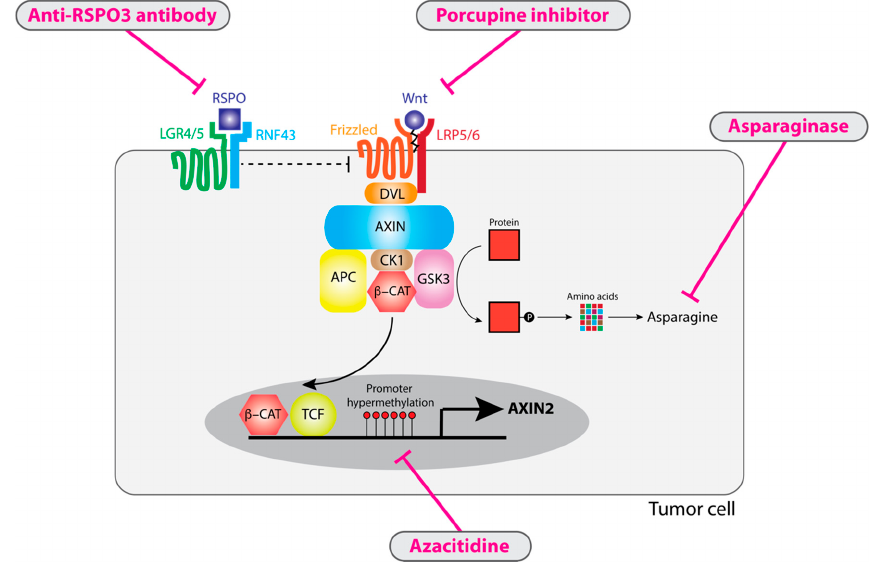
Figure 3. Target therapies for ligand-dependent tumors. All ligand-dependent tumors require Wnt ligands for pathway activation and so are sensitive to porcupine inhibitors that impair Wnt ligand activation. RSPO3 overexpression can be antagonized by anti-RSPO3 antibodies. Ligand-dependent GSK3 inhibition results in reduced proteasomal degradation to generate amino acids such as asparagine, making tumor cells sensitive to asparagine depletion with asparaginase treatment. Ligand-dependent tumors are characterized by AXIN2 repression which can be antagonized with licensed demethylating agents such as